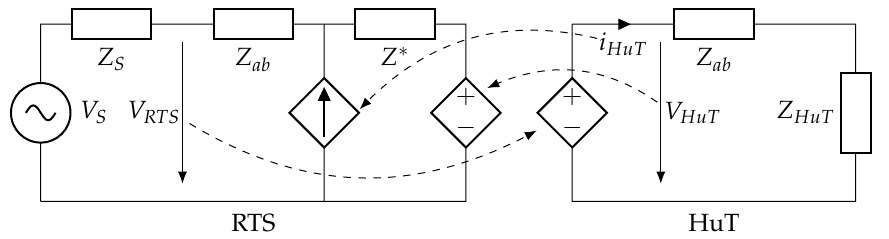
Figure 5. DIM interfacing algorithm for PHiL